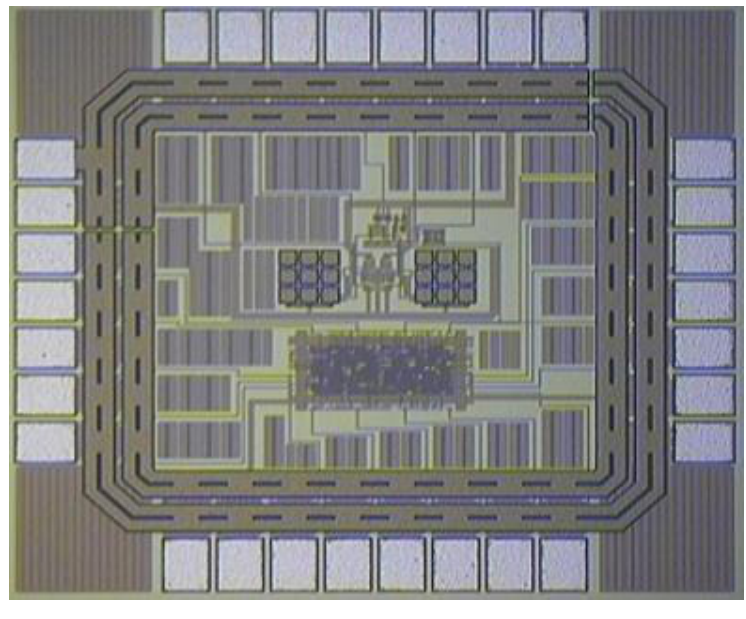
Figure 9. Die photo of this low-power mixed-signal SAW interface ASIC.